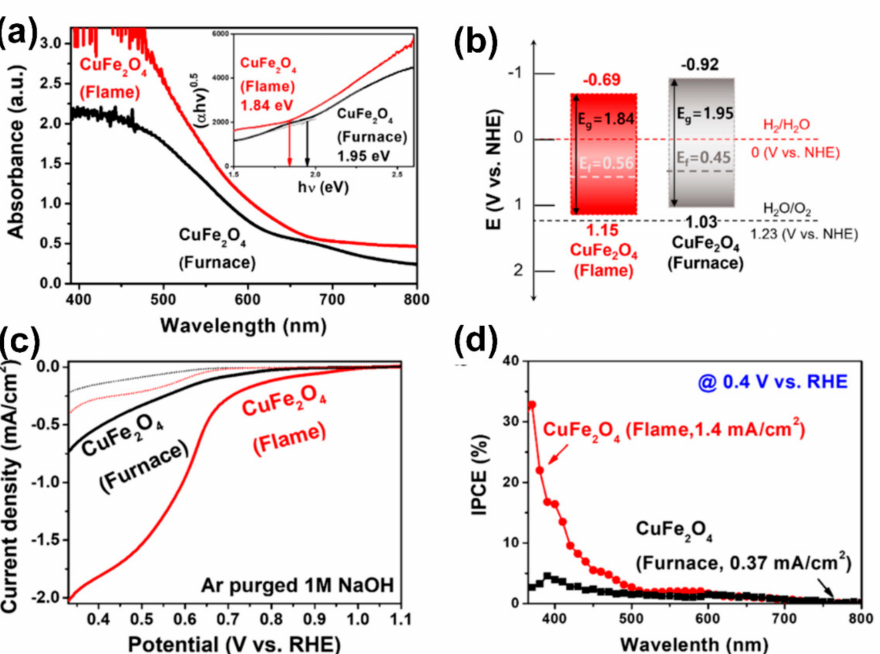
Figure 6. ( a ) UV-Vis Spectra of the rapid flame annealed and furnace annealed CuFe 2 O 4 films; ( b ) schematic illustration band structure diagram of the flame and furnace annealed CuFe 2 O 4 films; ( c ) J–V curves of the flame and furnace annealed CuFe 2 O 4 films; ( d ) IPCE of the flame and furnace annealed CuFe 2 O 4 films. Produced with the permission of ref. [48]. Copyright 2019, American Chemical